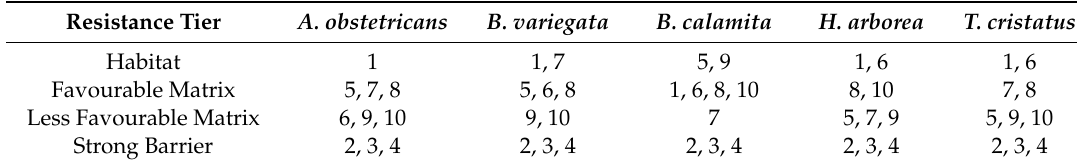
Table 2. Land—land use categories ranked into four tiers according to their resistance to movement for each species, increasing from low (habitat) to high (strong barrier).